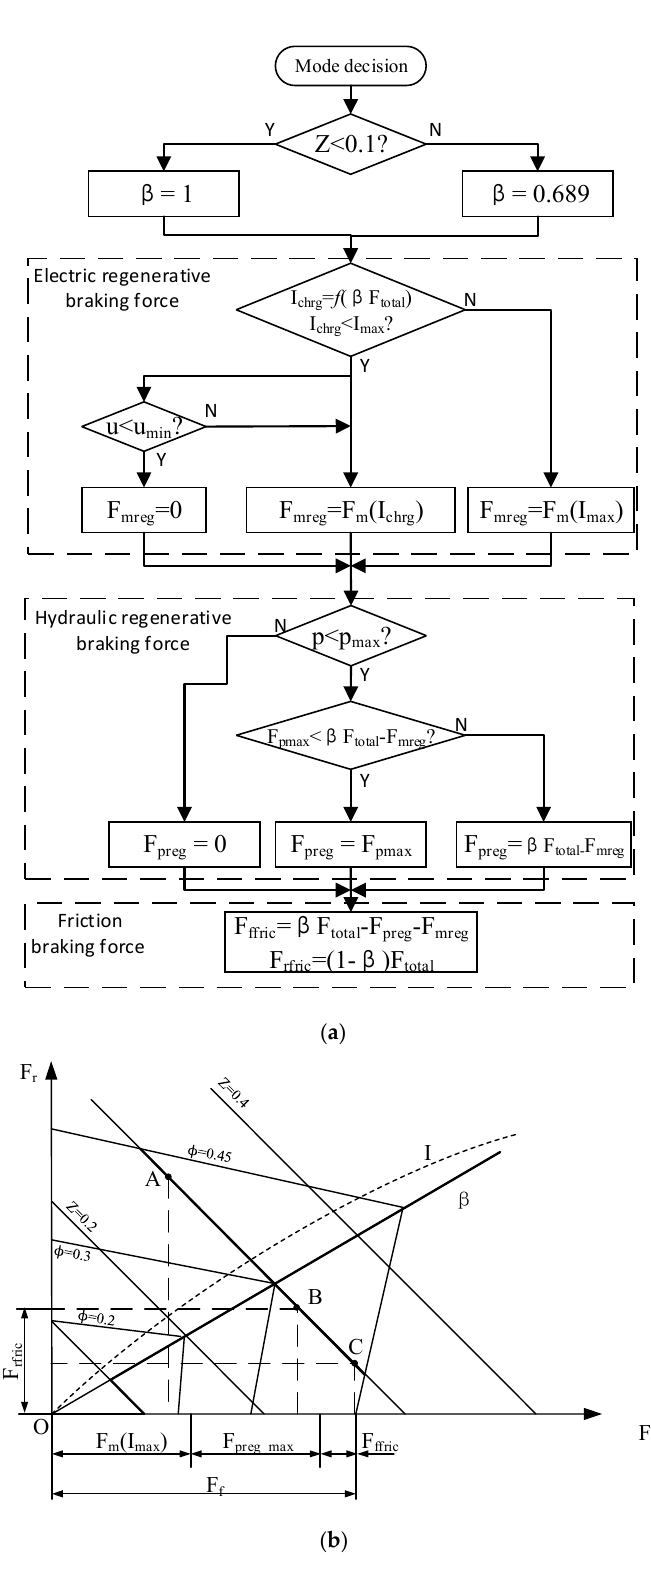
Figure 5. Braking force distribution by following the minimum current impact. ( a ) Braking force distribution strategy flow chart; ( b ) Braking force distribution curve.